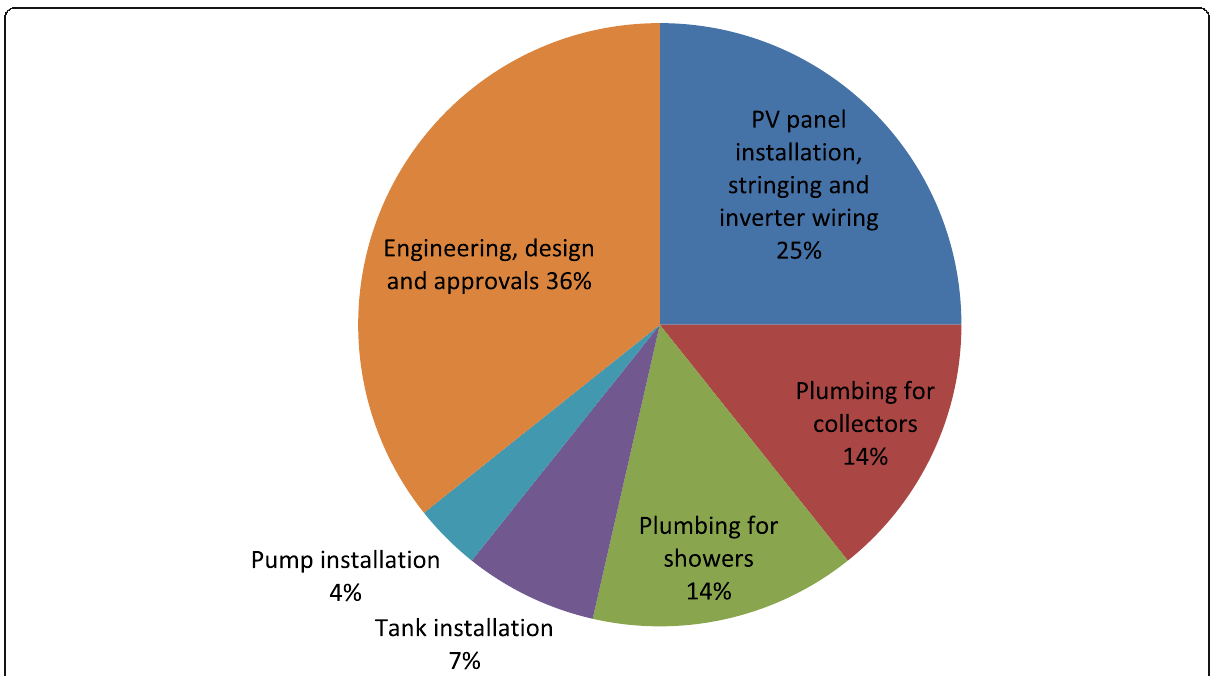
Fig. 4 Distribution of various installation costs involved in a typical PVT system